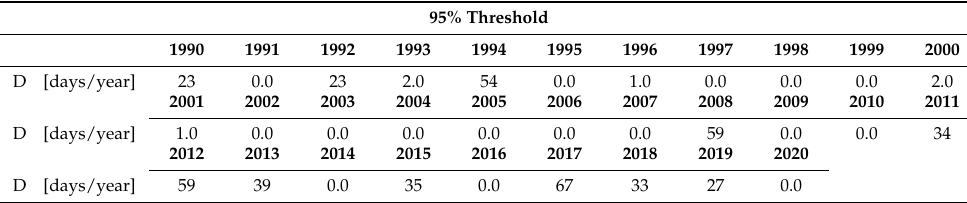
Table 6. The annual drought